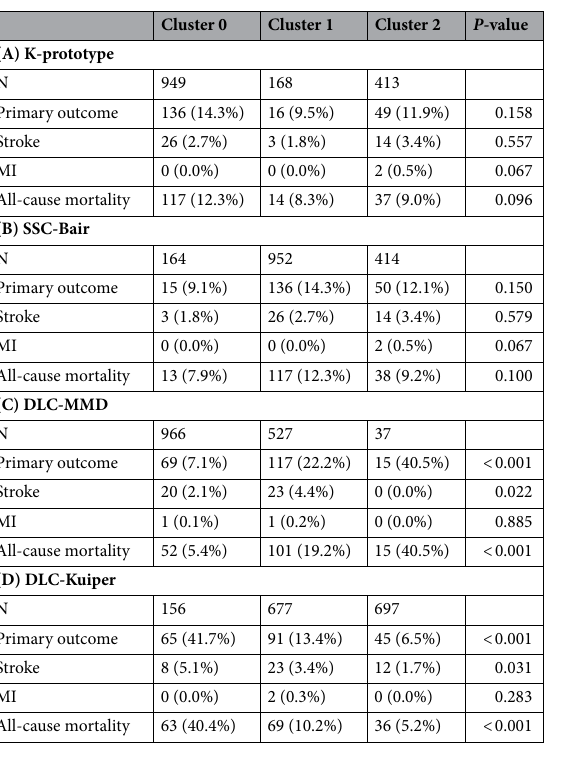
Table 3. One-year outcomes of patient groups according to the clustering method (k = 3/test set). P -value; Chi-squared